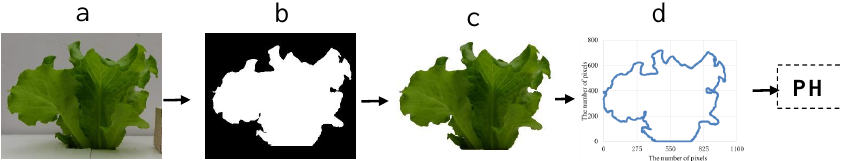
Figure 2. Extraction of PH from lettuce canopy front view images; ( a ) front view image of lettuce canopy, ( b ) binarization in front view image of lettuce canopy, ( c ) background segmentation in front view image of lettuce canopy, ( d ) plant height